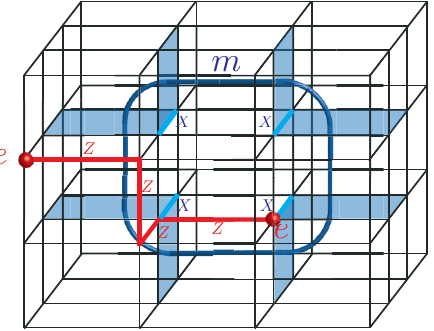
FIG. 11. The lattice realization of Fig. 10 with the 3D toric code model. A pair of e -particle excitations (red) are created from the ground state by a Z -string operator (four Pauli Z operators on the red edges) and the vertex stabilizers occupied by the e - particles are violated. An m -loop excitation (blue) is created from the ground state by an X -brane operator (four Pauli X operators on the blue edges) and the plaquettes (blue) penetrated by the m -loop are